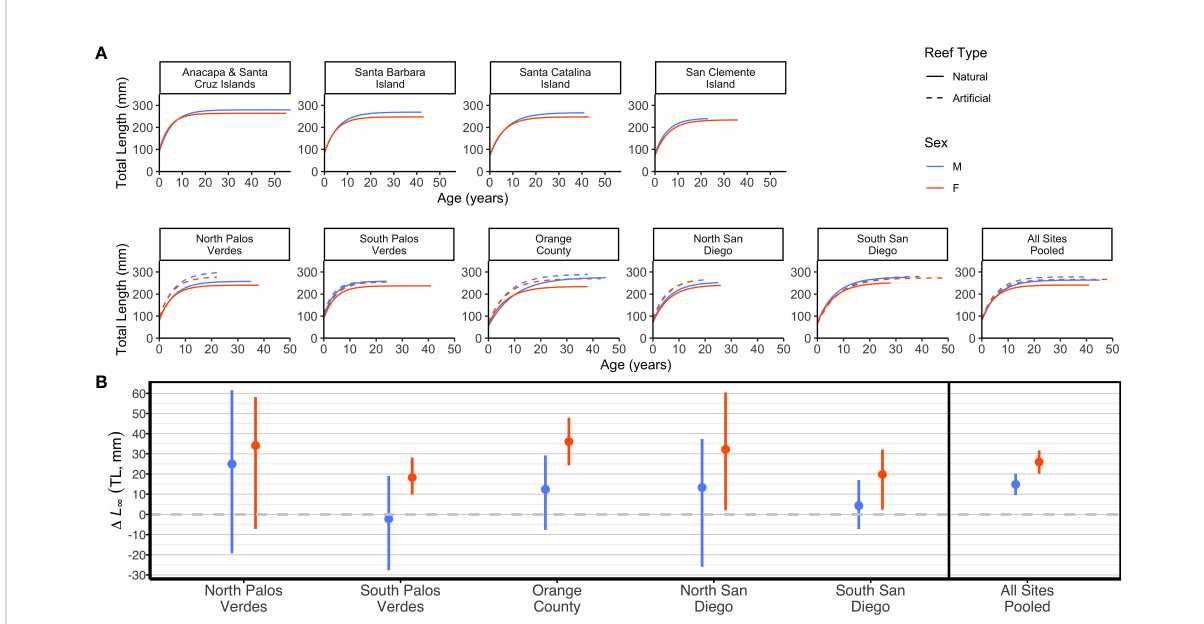
FIGURE 2 (A) Von Bertalanffy growth curves for Garibaldi ( Hypsypops rubicundus) by sex (color) and reef type (dashed/solid line) for each location (Channel Islands on top and mainland locations below), and all mainland locations pooled fi tted using maximum likelihood estimation. (B) Mean pairwise difference in L ∞ values by sex (color) between arti fi cial and natural rocky paired sites, and for all mainland sites pooled with bootstrapped 95% con fi dence intervals. The dashed line at D L ∞ = 0 represents no difference between the paired arti fi cial and natural reef sites, with a positive difference indicating adult Garibaldi were larger on the arti fi cial